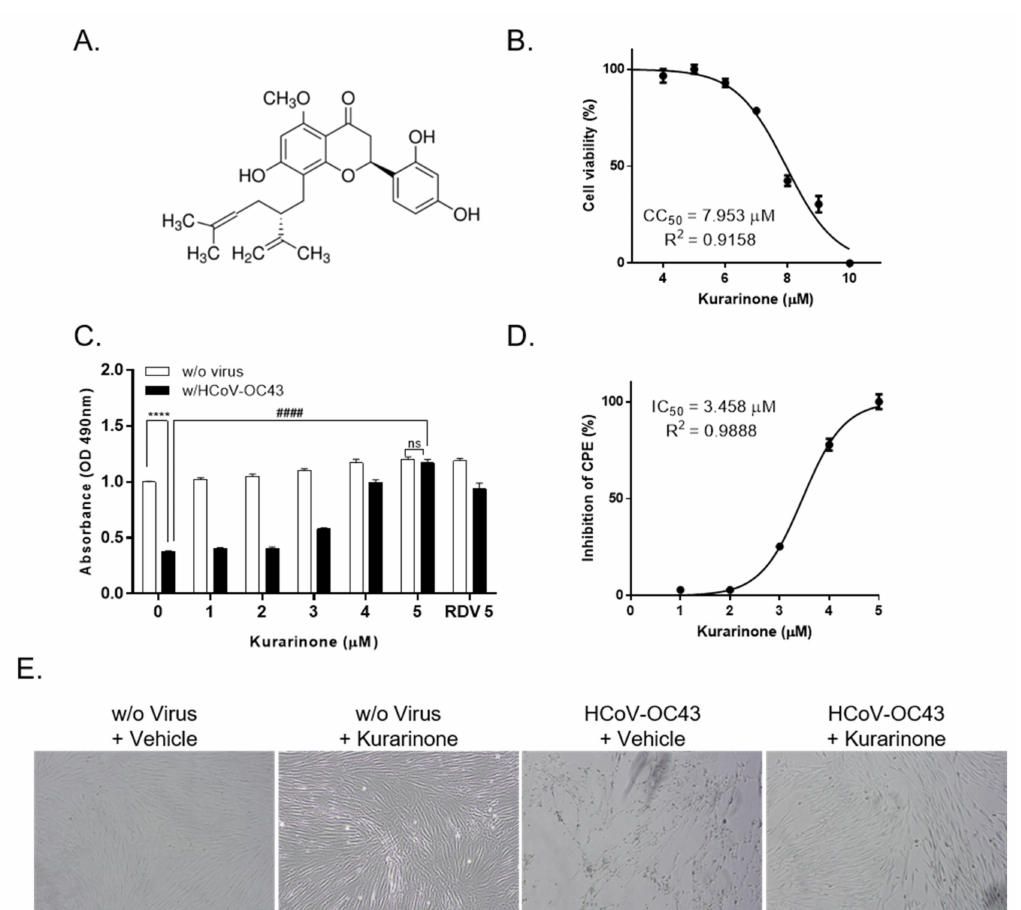
Figure 1. Chemical structure of kurarinone and antiviral activities in MRC-5 cells. ( A ) Chemical structure of kurarinone; ( B ) cytotoxicity associated with kurarinone. MRC-5 cells were incubated with increasing concentrations of kurarinone for 4 days; cell viability was measured by MTS assay (vehicle-treated cell as 100% of viability, 20% DMSO treated cell as 0% of viability). Cytotoxic concentration (CC 50 ) of kurarinone was calculated after 4 days by nonlinear regression analysis; ( C ) Antiviral impact of kurarinone determined by degree of virus-induced cytopathic e ff ect (CPE). MRC-5 cells were infected with HCoV-OC43 and incubated with various concentrations of kurarinone, or positive control, remdesivir (RDV) 5 µ M for 4 days; cell viability was measured by MTS assay; ( D ) Inhibitory concentration (IC 50 ) of kurarinone was calculated at 4 days post-infection (dpi) by nonlinear regression analysis. (vehicle-treated virus-infected cell as 0% of inhibition, vehicle-treated non-virus infected cell as 100% of inhibition); ( E ) Images of virus-infected MRC-5 cells at 4 dpi. Data were presented as means ± SEM of three independent experiments, and analyzed by two-way ANOVA with Bonferroni’s multiple comparisons test and nonlinear regression analysis. Virus e ff ect, F(1, 36) = 1522; dose e ff ect, F(5, 36) = 238.6; virus × dose interaction, F(5, 36) = 93.39; n.s., not significant; **** p < 0.0001; #### p <